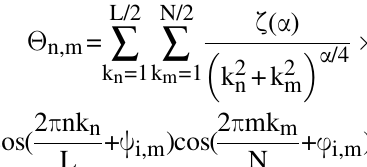
Figure 4 - a) Calculations of the energy flux through the harmonic lattice with correlated disorder. We plot Z n versus t for N = 2400 , L = 360 , n 0 = L/2 , z 0 = 1300 and α = 0 , 1 and 3 . b) I( ω ) = |FT(Z n 0 ,z 0 versus ω for several values of α . For α > 2 , our calculations suggest the existence of a phase of extended vibrational modes with frequencies within the interval [0, ω c ]